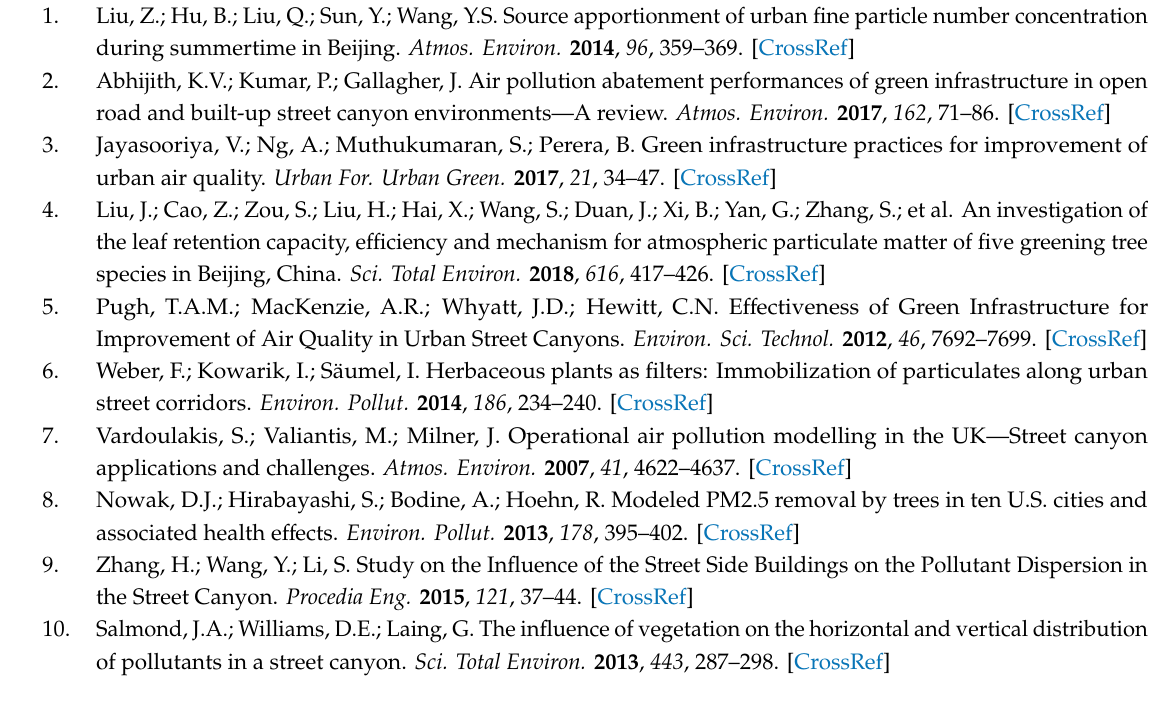
Table S1: Air Quality Index, Table S2: Street Length, Table S3: GVI_Site and